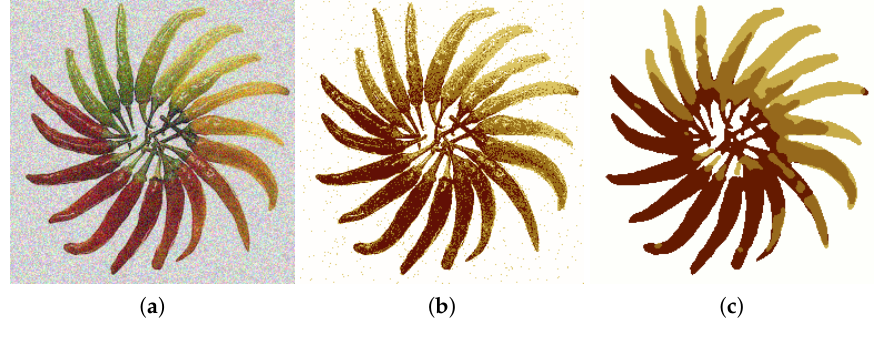
( a ) Original image, ( b ) k-means segmentation that is used to initialize φ 1 and φ 2 ( c ) segmentation